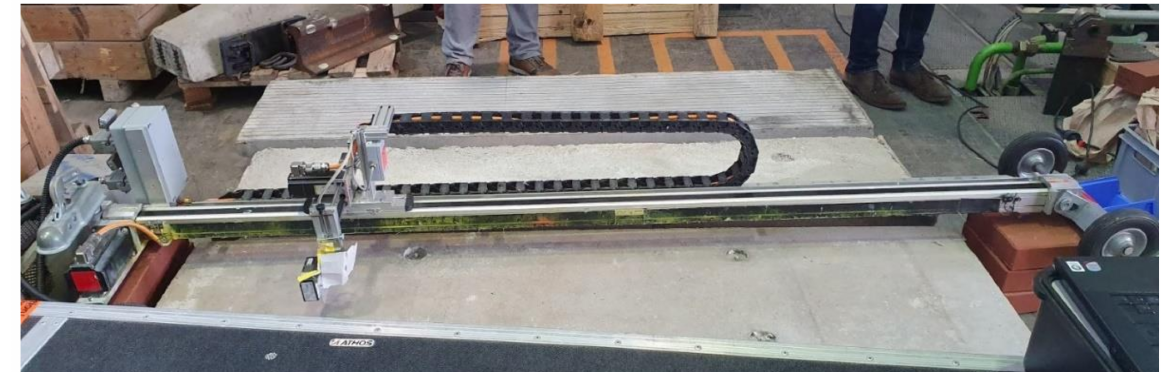
Figure 3. Laser profilometer for surface texture